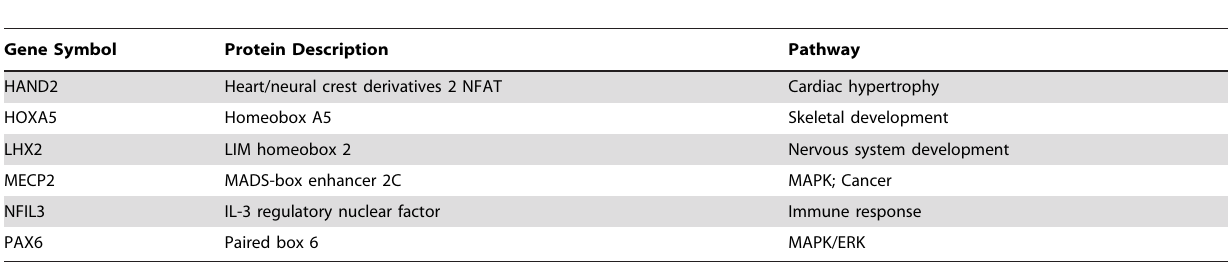
Table 3. Transcription factors binding to Ankrd2 promoter